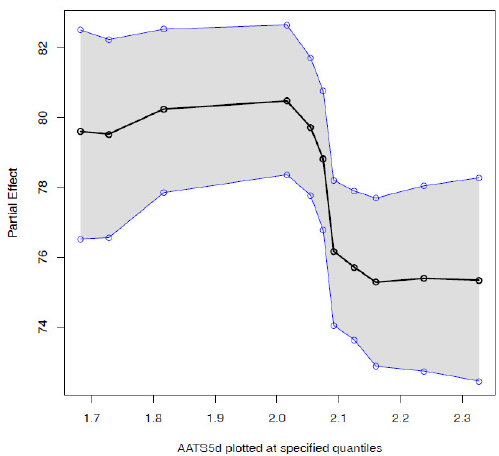
Figure 3. Partial dependence plot for AATS5d. This plot facilitates the understanding of how the dispersancy value is affected as a given descriptor is